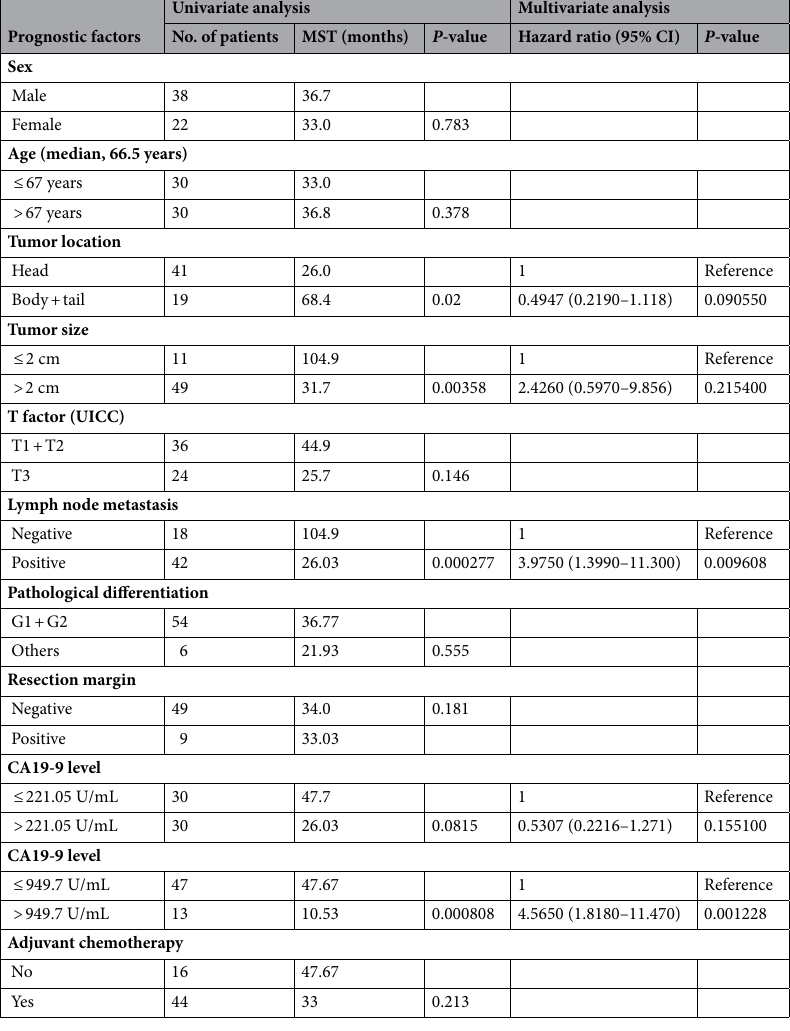
Table 4. Univariate and multivariate analyses of overall survival in surgery group. MST, median survival rate; CI, confidence interval; UICC, Union for International Cancer Control; CA19-9, carbohydrate antigen 19-9; ctDNA, circulating tumor